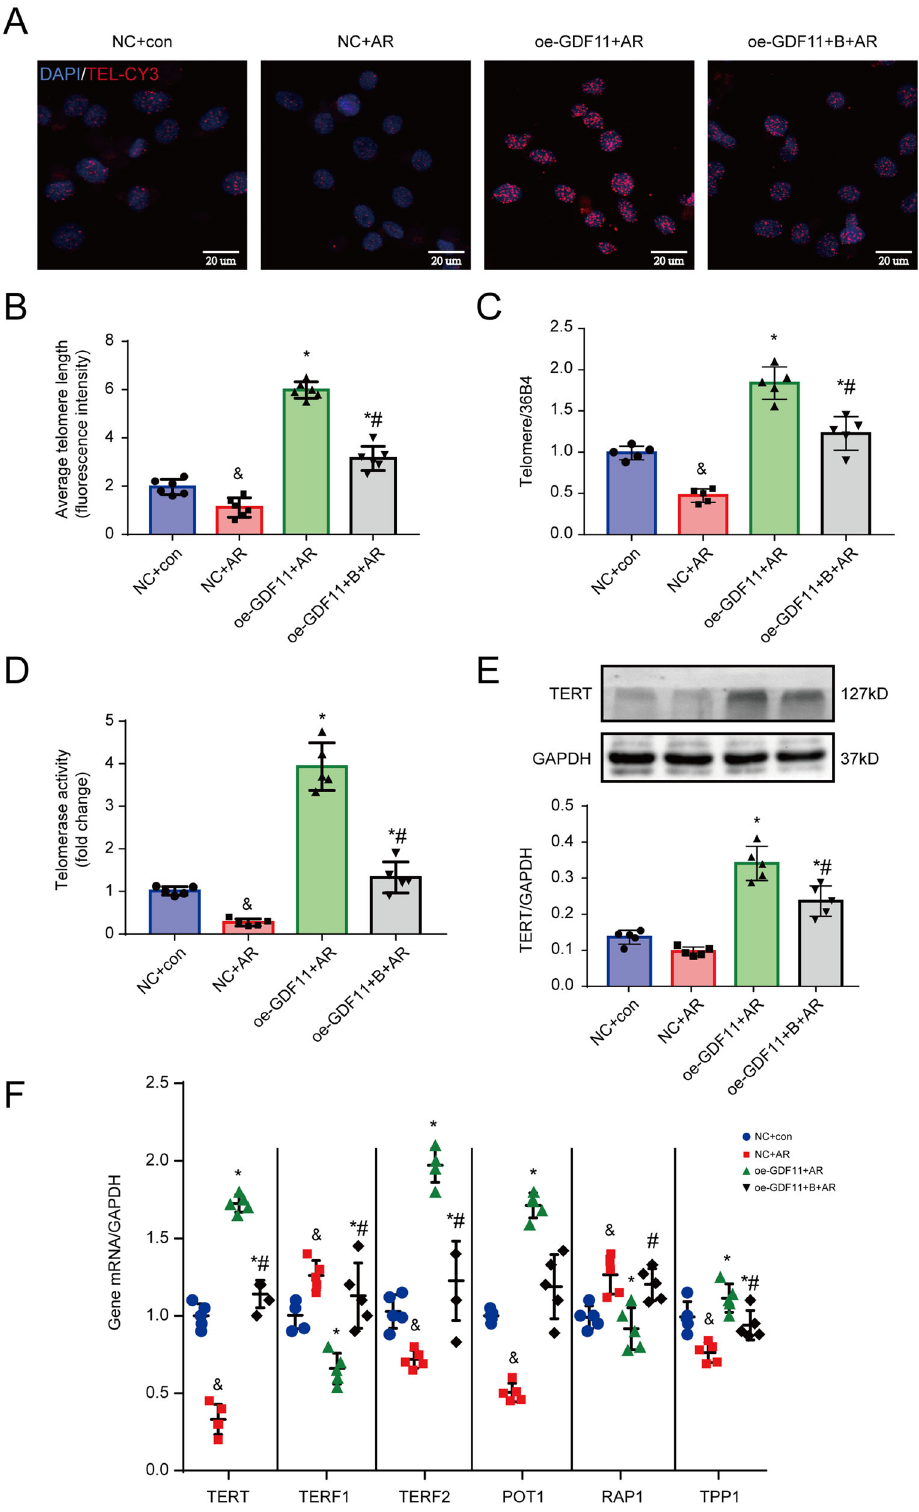
Fig. 6 GDF11 activated telomerase and inhibited telomere shortening in NRCMs under AR. A Representative photographs of telomeres measured by Q-FISH in NRCMs. B Quantitative analysis of the TL of TEL-CY3-positive cells. C TL measured by real-time PCR. D The activity of telomerase. E Representative western blot images and semiquantitative analysis of TERT. F mRNA expression of TERT, TERF2, POT1, TPP1, TERF1, and RAP1. & p < 0.05 vs. the NC group; * p < 0.05 vs. the AR group; # p < 0.05 vs. the oe-GDF + AR group; n = 6 in each group in panel ( B ) and n = 5 per group in panels ( C – G ); one-way ANOVA followed by Bonferroni ’ s correction for post hoc multiple comparisons in panel ( B – D , F , G ). ( B ) The telomerase inhibitor BIBR1532; GDF11 growth differentiation factor 11, oe-GDF11 GDF11 overexpression, TL telomere